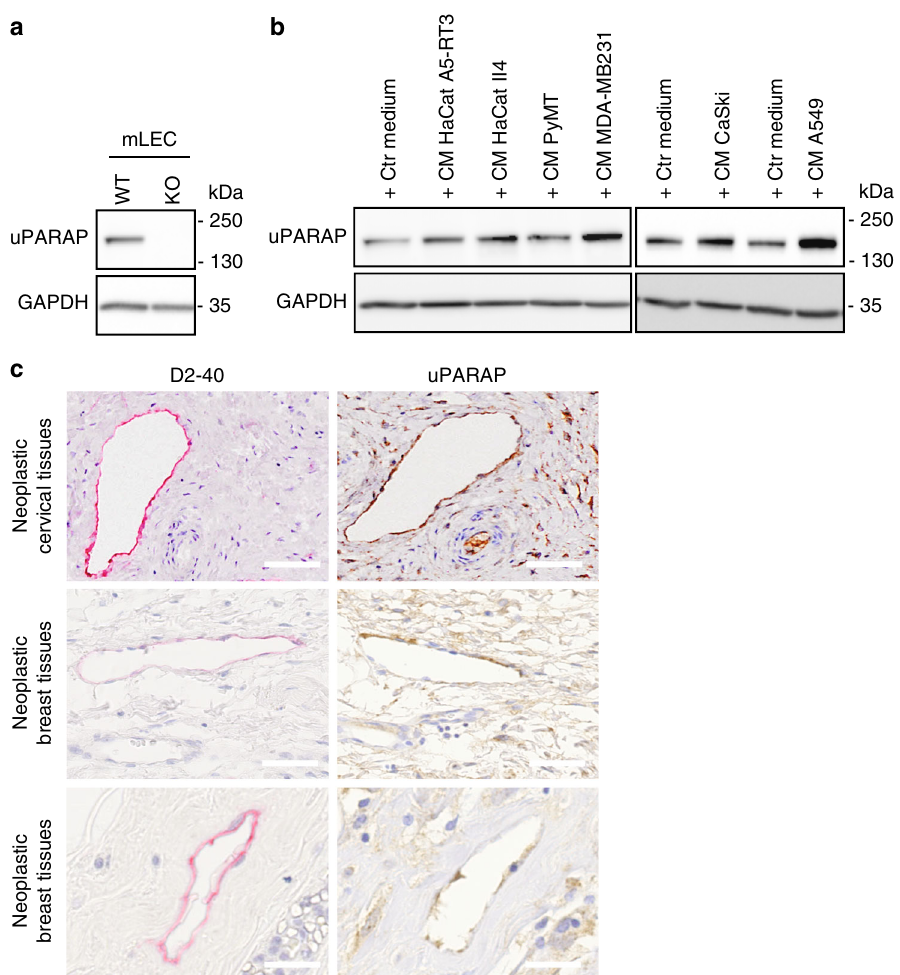
Fig. 3 uPARAP is expressed by human and murine LECs. a uPARAP expression was assessed by Western Blot on LECs isolated from uPARAP -pro fi cient (WT) and de fi cient (KO) mice. b Human LECs were incubated with conditioned media from indicated tumor cell lines and Western Blot of uPARAP was performed. GAPDH was used as a loading control. c Immunostainings of lymphatic vessels (pink, D2-40) and uPARAP (brown) on serial sections of human neoplastic cervical and breast tissues. Bars = 50 µ m (upper and middle panels) and 25 µ m (lower